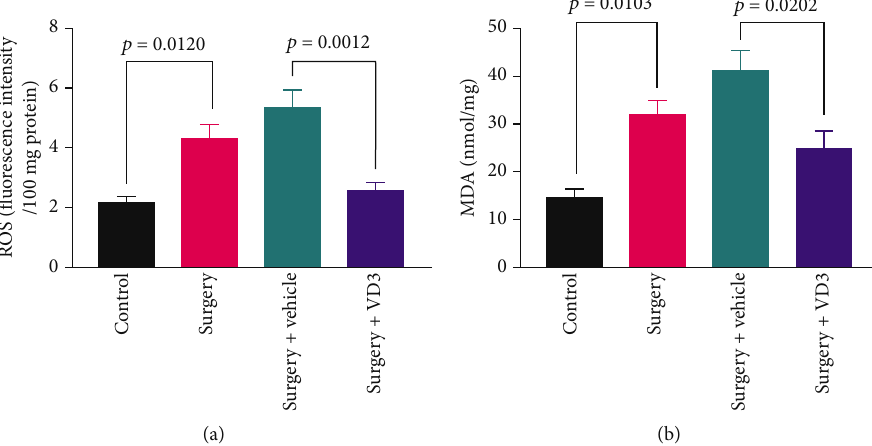
Figure 7: Expression levels of (a) ROS and (b) MDA in the hippocampus 24 hours after surgery. Data are presented as means ± SD ( n = 5 per